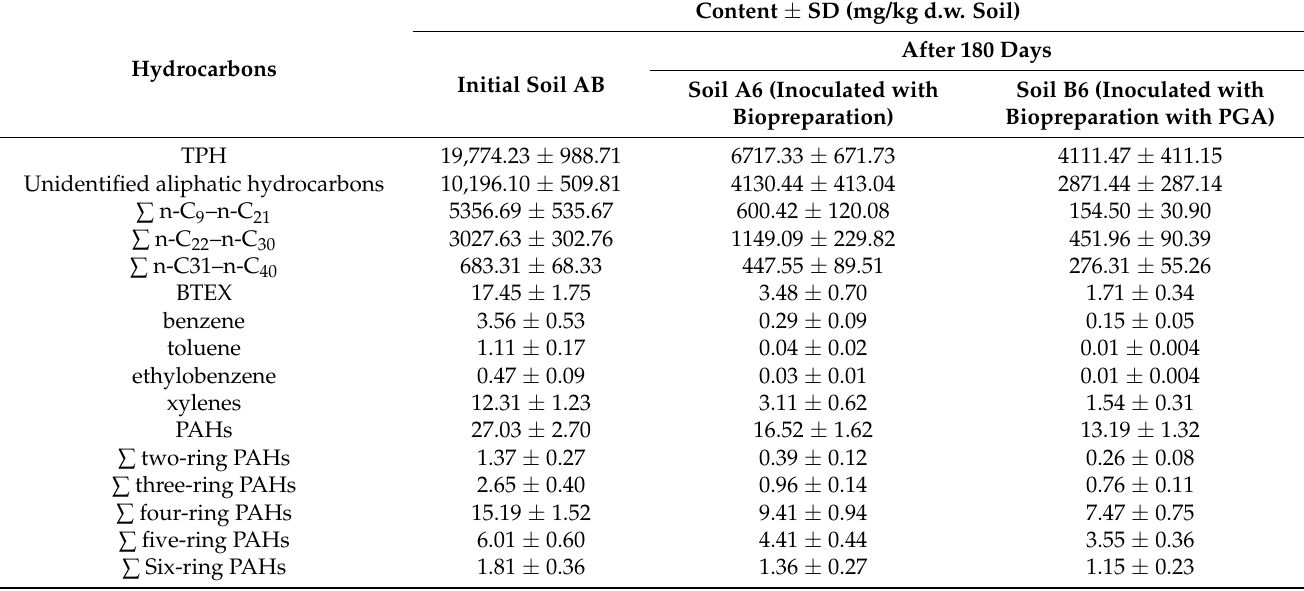
Table 3. Summary of the content of petroleum hydrocarbons (TPH, BTEX, PAHs) in soil AB and after the completion of the biodegradation process with the use of biopreparation A1 (Soil A6) and biopreparation A1 with the addition of γ -PGA (Soil B6), (repetition number n = 7–10, p <